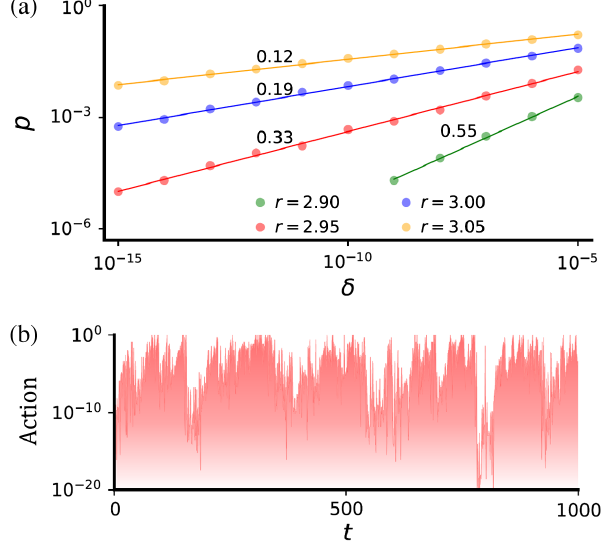
FIG. 6. Action profile for transition paths. (a) Probability p of finding small-action transition paths by introducing a short- wavelength perturbation of magnitude δ in a single iteration. The simulations are performed for ξ ¼ 0 , and the other param- eters are the same as in Fig. 2. Paths with arbitrarily small action exist, but small-action paths become increasingly more difficult to find as the available action is decreased, resulting in power-law relationships between the probability p and the perturbation size δ . Notice that the scaling exponents here match those in δ 2 ) needed to induce a transition by Fig. 2. (b) Minimum action ( 1 2 δ Þ at a given time t , for ξ ¼ 0 , σ ¼ 1 . 7 , and applying Δ sw ð r ¼ 2 . 95 . This highly structured profile can be regarded as a visualization of the transition-barrier landscape for switching